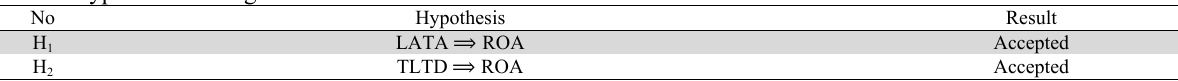
Result of hypothesis